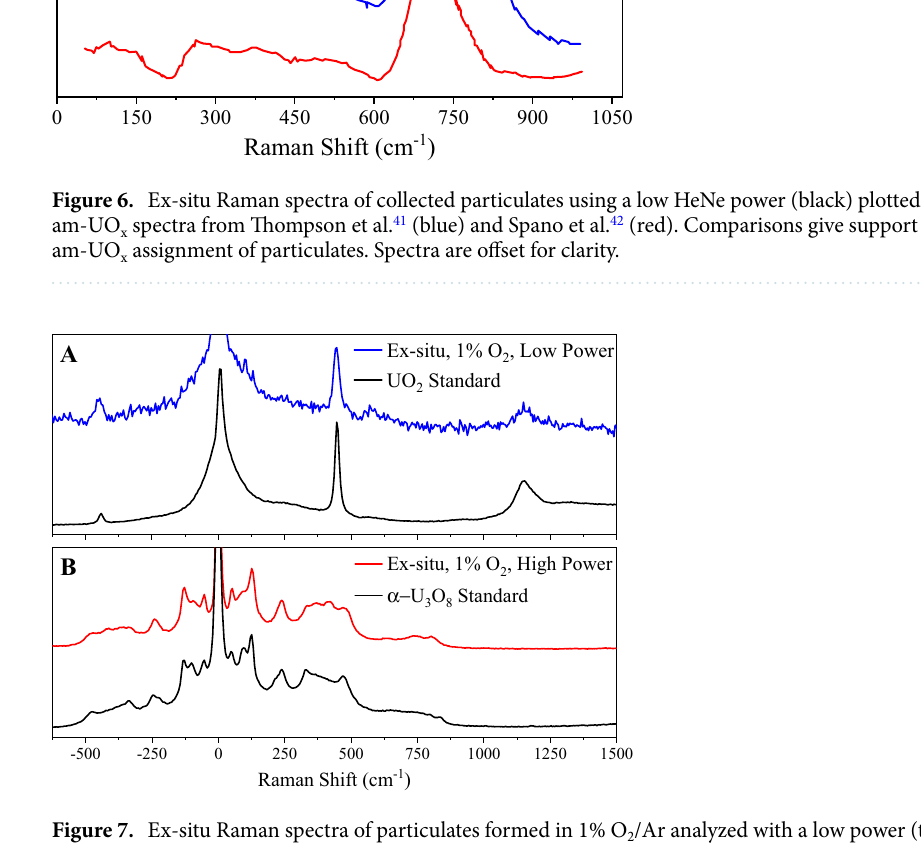
Figure 7. Ex-situ Raman spectra of particulates formed in 1% O 2 /Ar analyzed with a low power (top, A) and high power (bottom, B) HeNe beam. Also shown are spectra for α-U 3 O 8 and UO 2 standards. A low power HeNe beam indicates UO 2 is formed during the ablation process; however, with sufficient heat, particulates can be converted to α-U 3 O 8 . Spectra are offset for